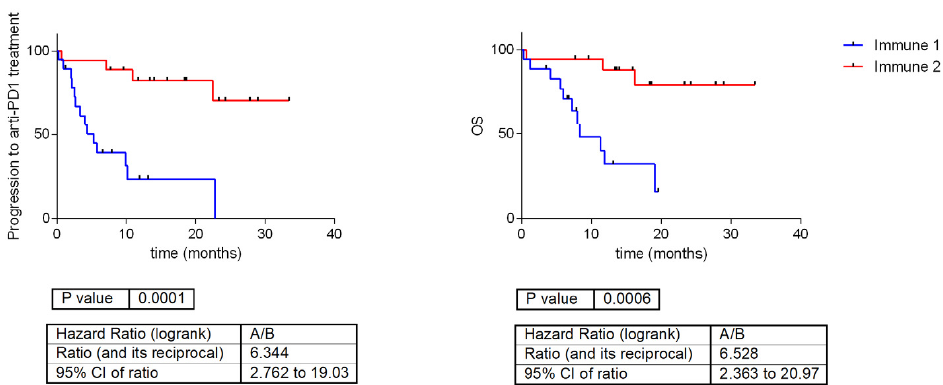
Figure 5. Survival curves according immune information previously defined in TCGA cohort in GEM cohort treated with anti-PD1 inhibitors. Immune 1 is the “immune-low group”, showing lower expression of immune-related genes, and Immune 2 is the “immune-high group”, presenting higher expression of immune-related genes. OS = overall survival.